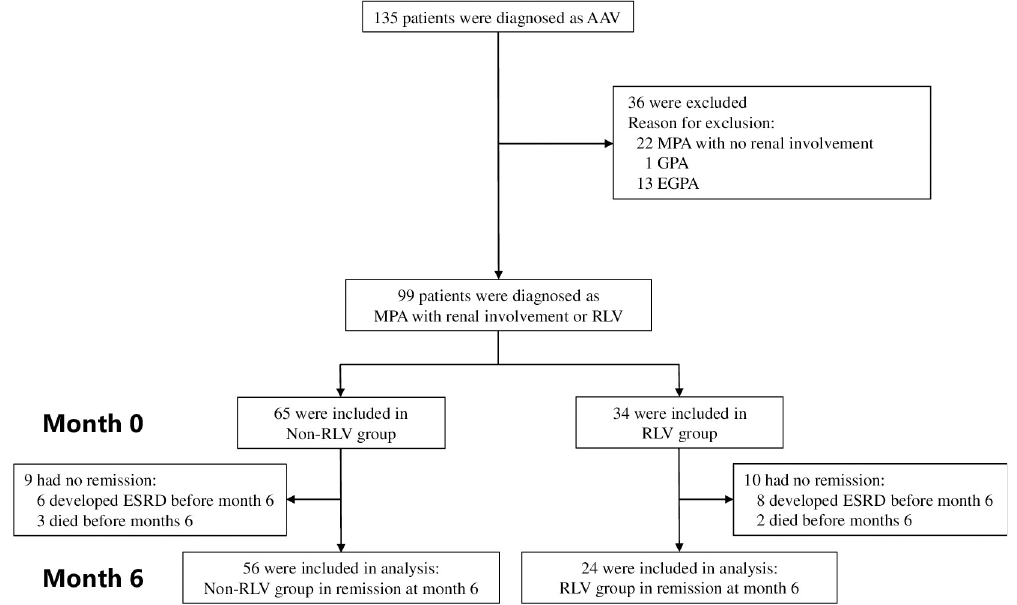
Fig 1. Flow diagram of patient selection. AAV, antineutrophil cytoplasmic autoantibody–associated vasculitis; EGPA, eosinophilic granulomatosis with polyangiitis; GPA, granulomatosis with polyangiitis; MPA, microscopic polyangiitis; RLV, renal-limited